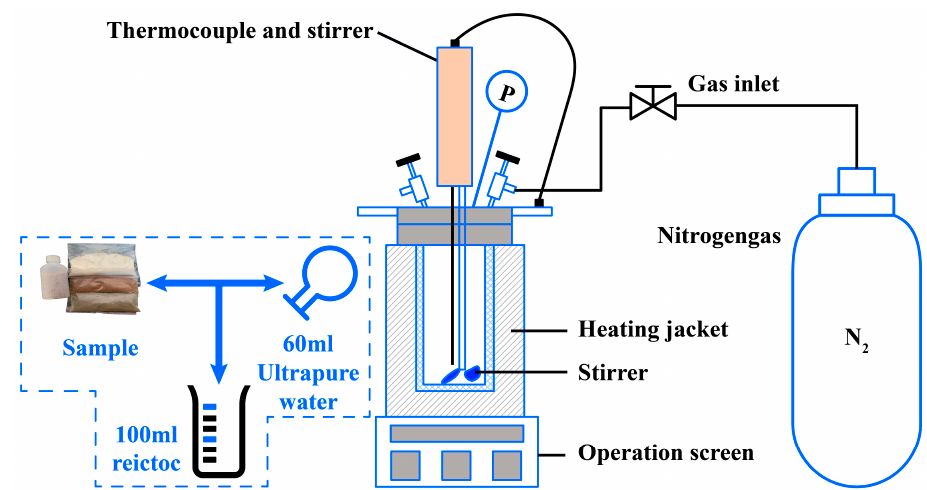
Figure 2. Hydrothermal carbonization experimental device diagram.